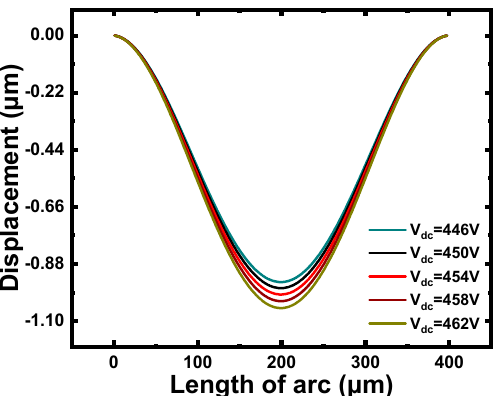
Figure 6. The displacement curves of C1 with different bias voltages.